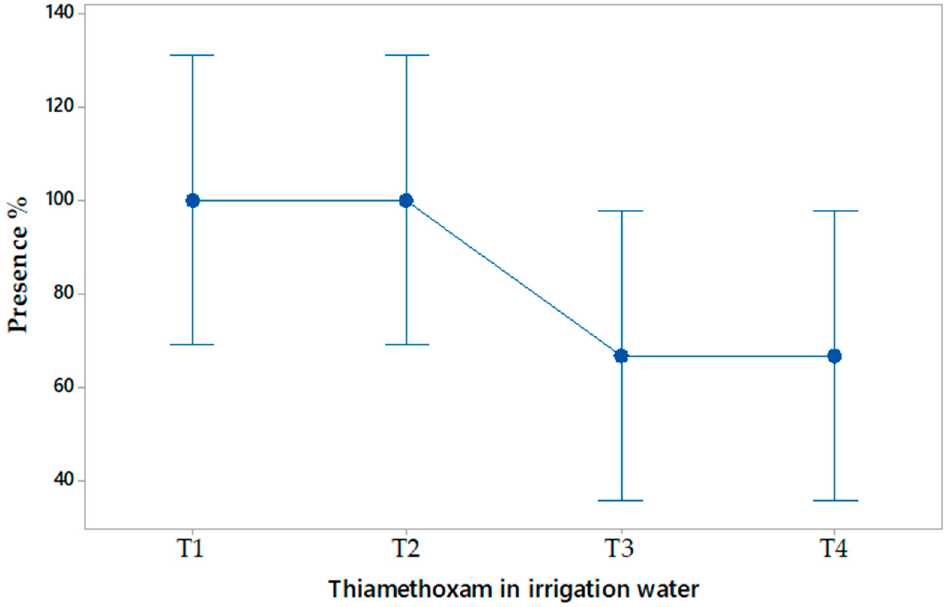
Figure 7. Presence percentage of thiamethoxam in irrigation water in the papaya crop rotation with watermelon in an experimental plot. There were no significant statistical di ff erences ( p > 0.05) in all the treatments analyzed.